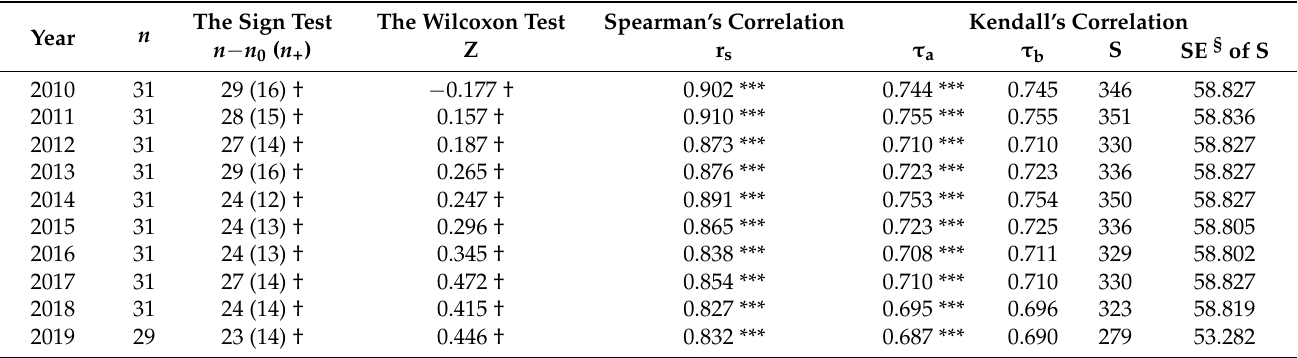
Table 5. Results of the sign test, Wilcoxon test and Spearman’s and Kendall’s correlation tests for SPH ranks for the total population and the older subpopulation in 2010–2019.